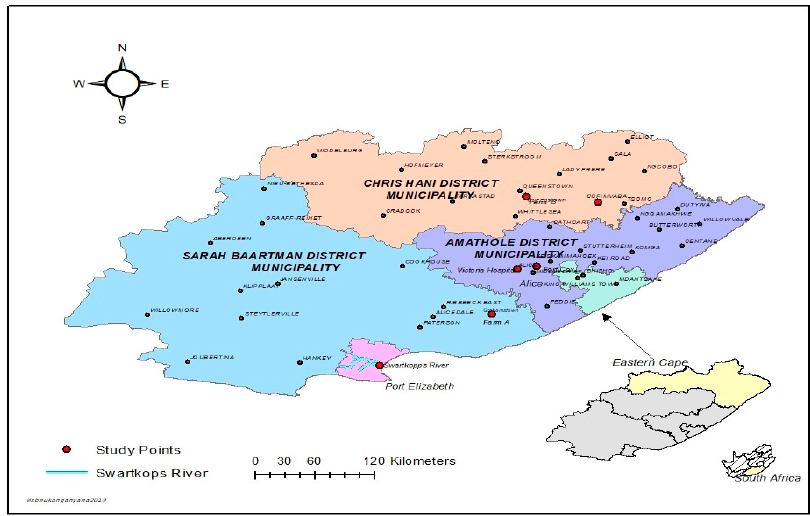
Figure 1. Map showing the study areas in the district municipalities.